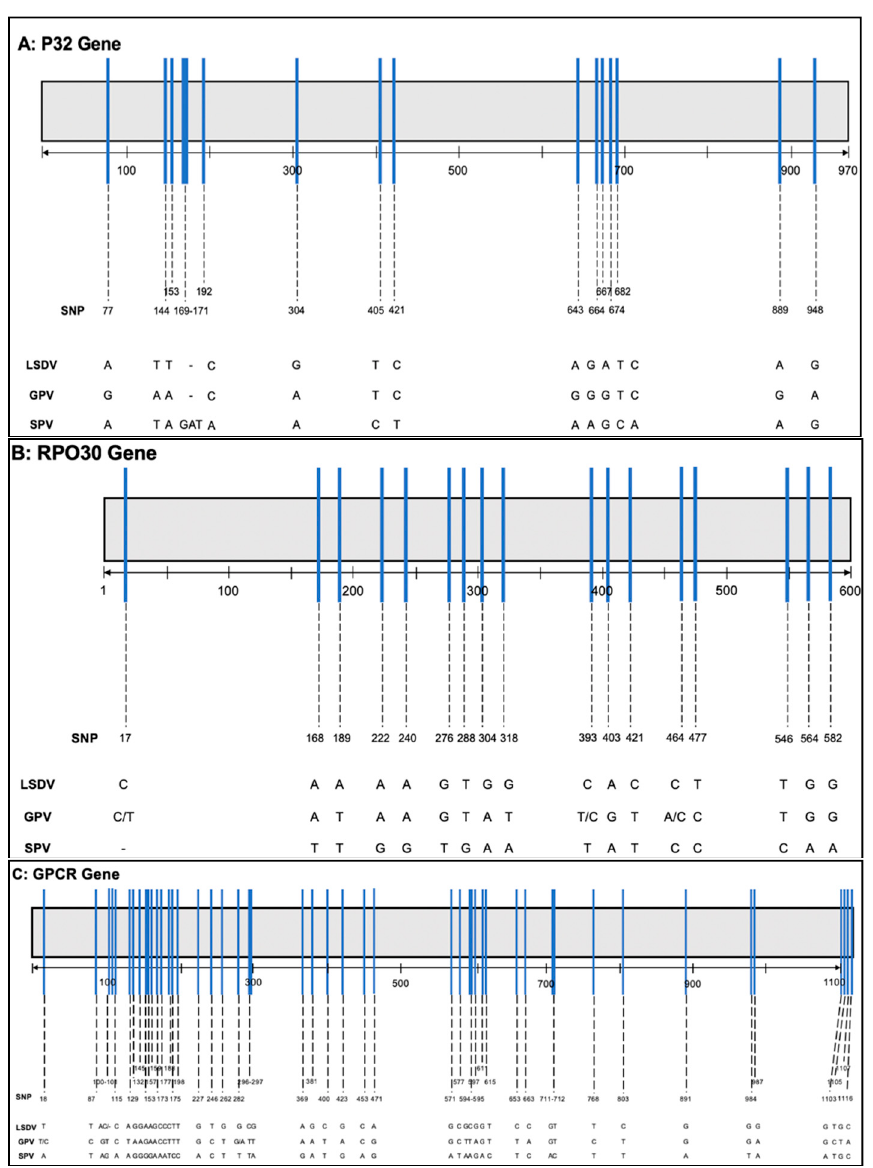
Figure 4. Single-nucleotide polymorphism (SNP) mapped to ( A ) P32 gene, ( B ) RPO30 gene and ( C ) GPCR gene. The single nucleotides of each position are shown below for LSDV, GPV and SPV. When the WIMP tool included in the desktop application EPI2ME of Oxford Na- nopore Technologies was further tested as an online alternative, an average of 84.48% of